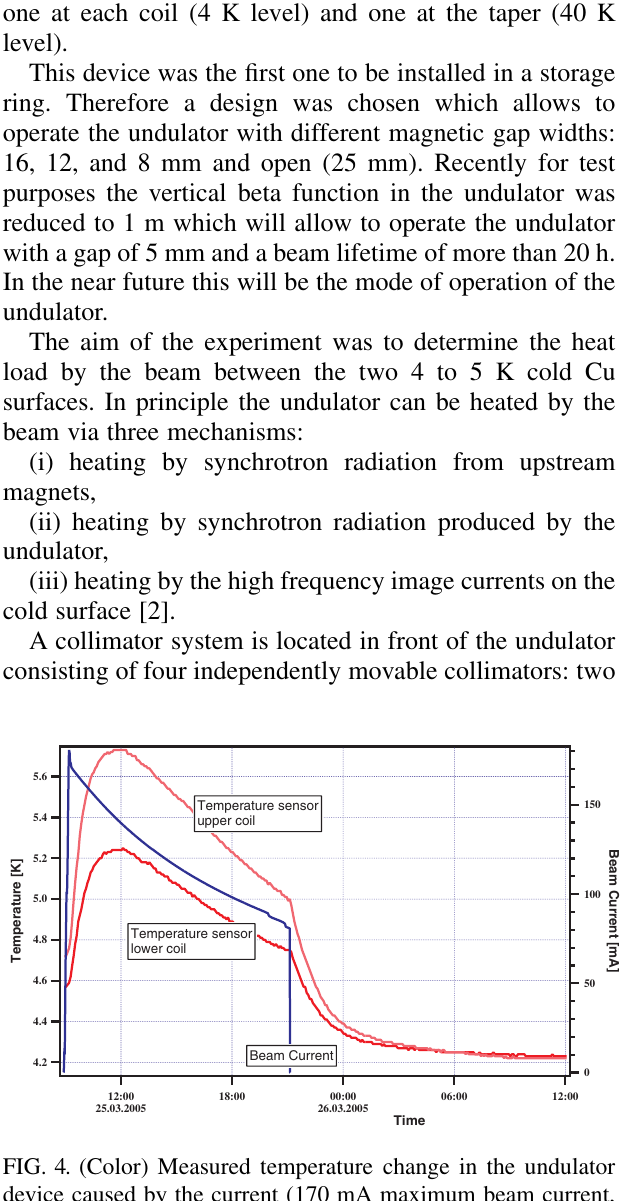
FIG. 3. (Color) Schematic layout of the superconductive undulator. The position of the temperature sensors are marked. temperature sensors are marked in this schematic drawing: one at each coil (4 K level) and one at the taper (40 K level).